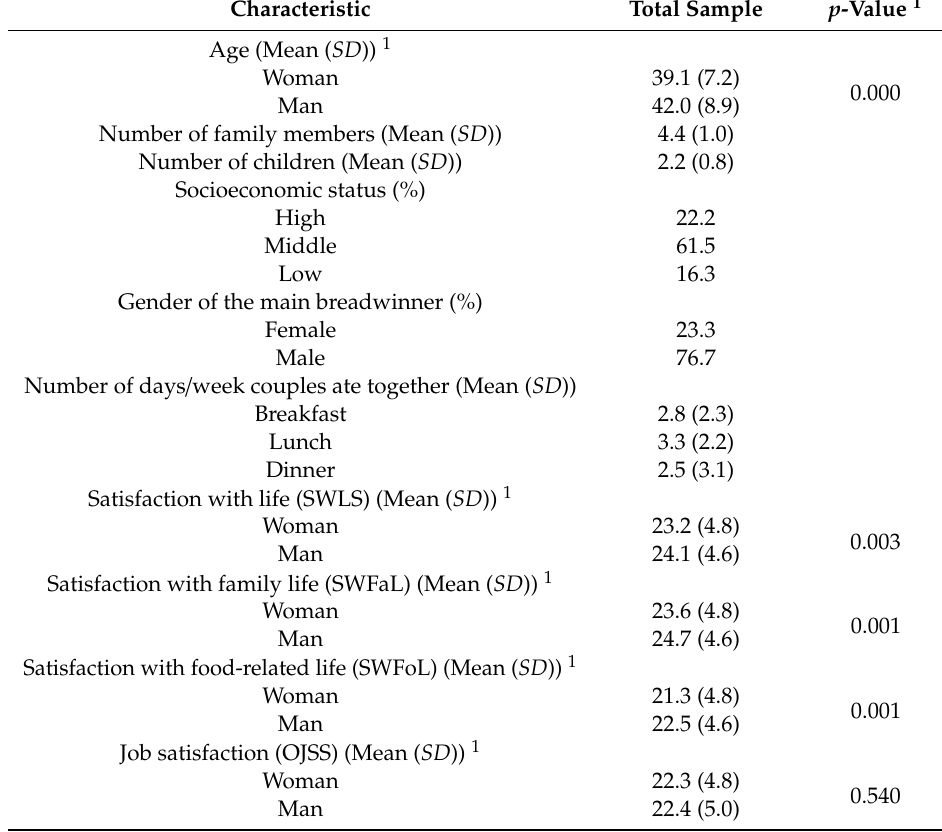
Table 1. Sample characteristics of participant couples (n =